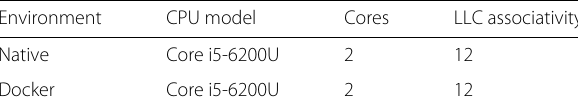
Table 4 Experimental